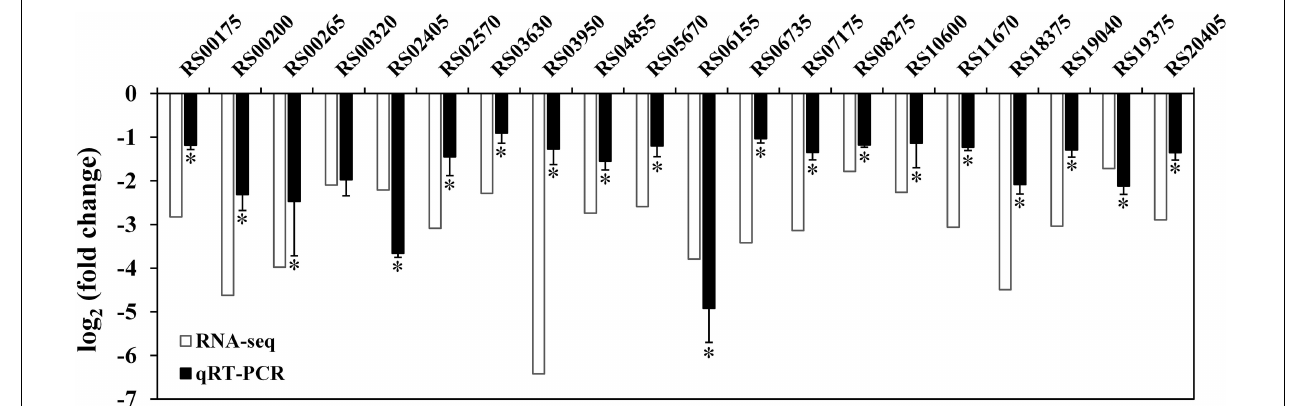
FIGURE 7 | Confirmation of RNA-seq results using qRT-PCR. White bars represent RNA-seq data, while the black bars represent the mean values of log 2 (fold change) obtained from the rpoN mutant samples compared with the wild-type samples. Data are presented as the mean ± SD ( n = 6). Significant differences between the values of RNA-seq and qRT-PCR are analyzed by one-sample t -test. ∗ p <